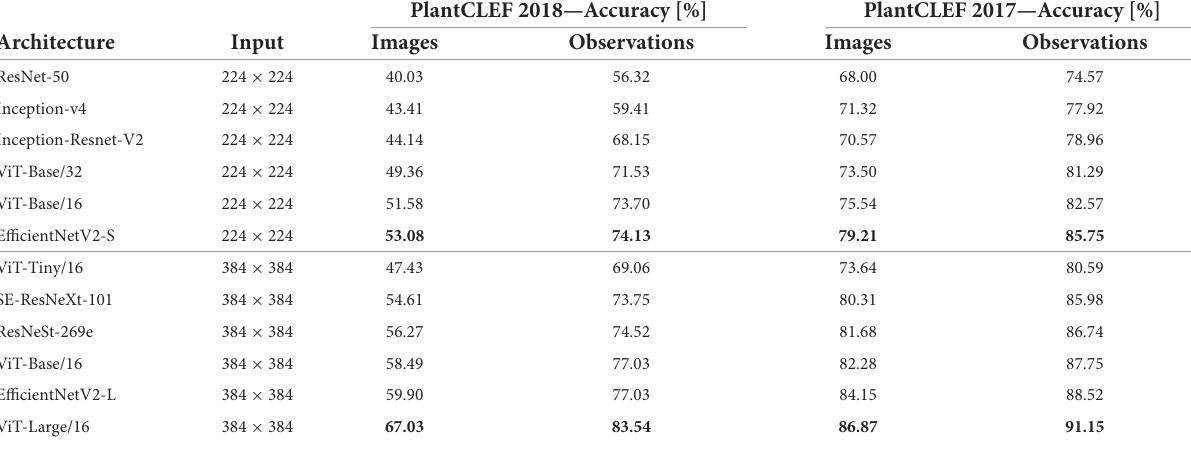
TABLE 3 Image classification accuracy for Deep Neural Network Classifiers on the PlantCLEF 2017 (right) and ExpertLifeCLEF 2018 (left) test